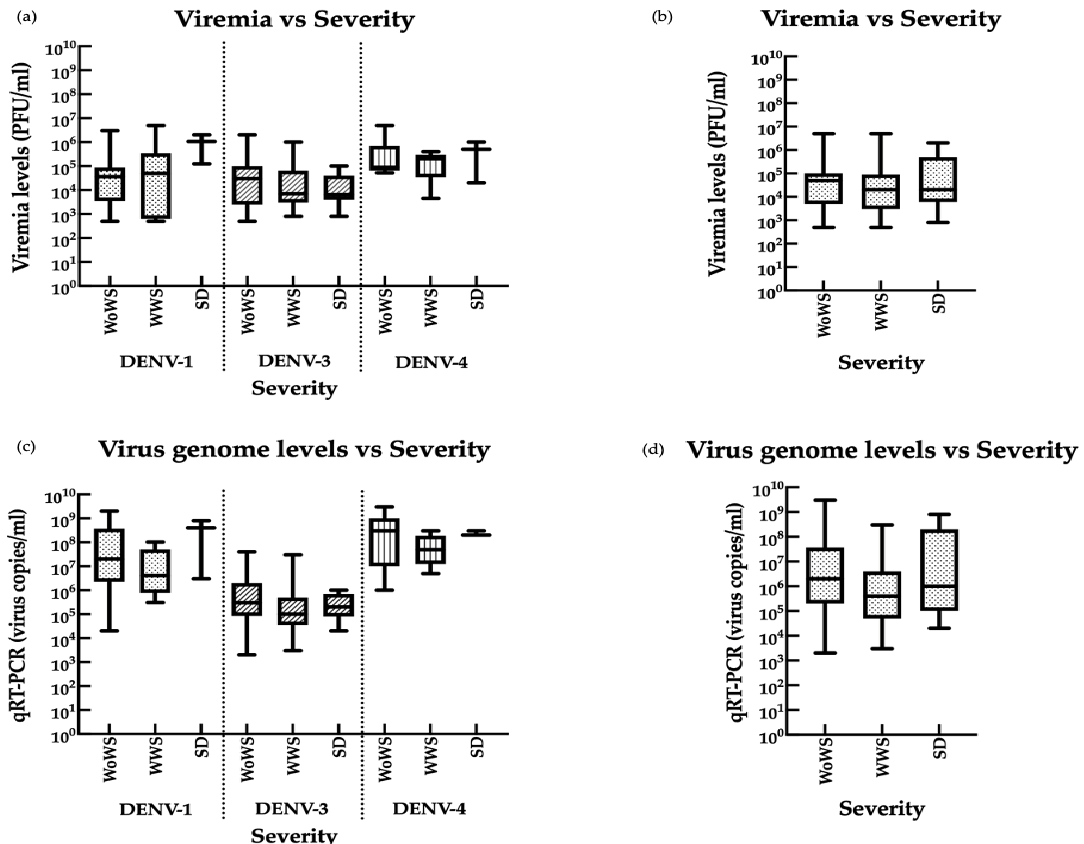
Figure 7. Comparison of viremia and disease severity in patients infected with DENV-1, DENV-3, and DENV-4. ( a – d ) Serum DENV-1 ( n = 31), DENV-3 ( n = 76), and DENV-4 ( n = 15) levels determined by ( a , b ) plaque assay and ( c , d ) qRT-PCR. Data are presented for each serotype individually ( a , c ) or in combination ( b , d ). WoWS, without warning signs; WWS, with warning signs; SD, severe dengue (WHO classification). Boxplots show the median values (horizontal line in the box), 25–75% interquartile range (lower–upper limits of the